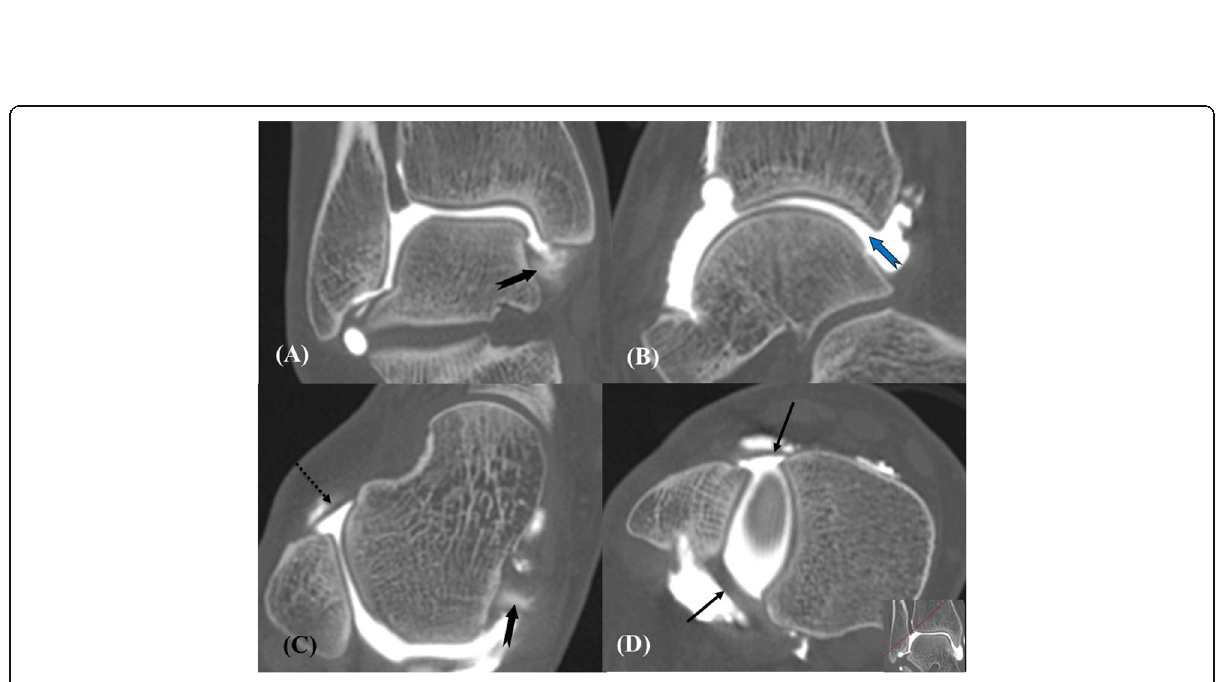
Fig. 2 Right subacute medial ankle pain following medial sprain. Coronal ( a ) CTA demonstrates contrast medium within the posterior band of the deep deltoid (notched arrow). Sagittal ( b ) CTA shows uneven joint space that widen posteriorly (blue arrow). Axial ( c ) CTA demonstrates normal ATFL (dashed arrow). Oblique image though syndesmotic ligaments ( d ) shows intact anterior inferior tibio-fibular ligament and posterior inferior tibio-fibular